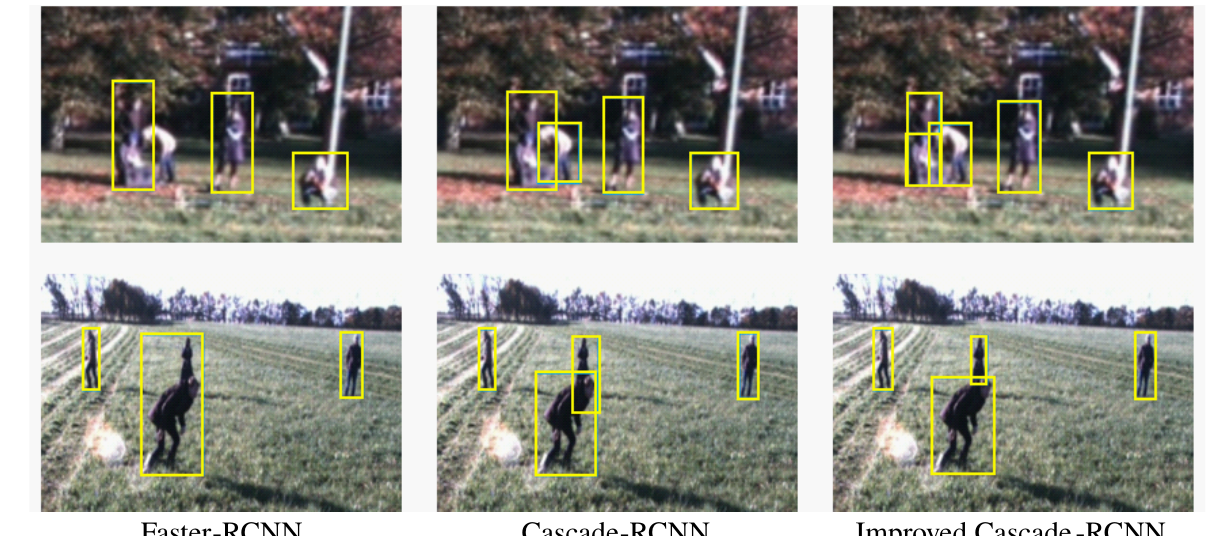
Figure 5. Examples of 2D detection results.